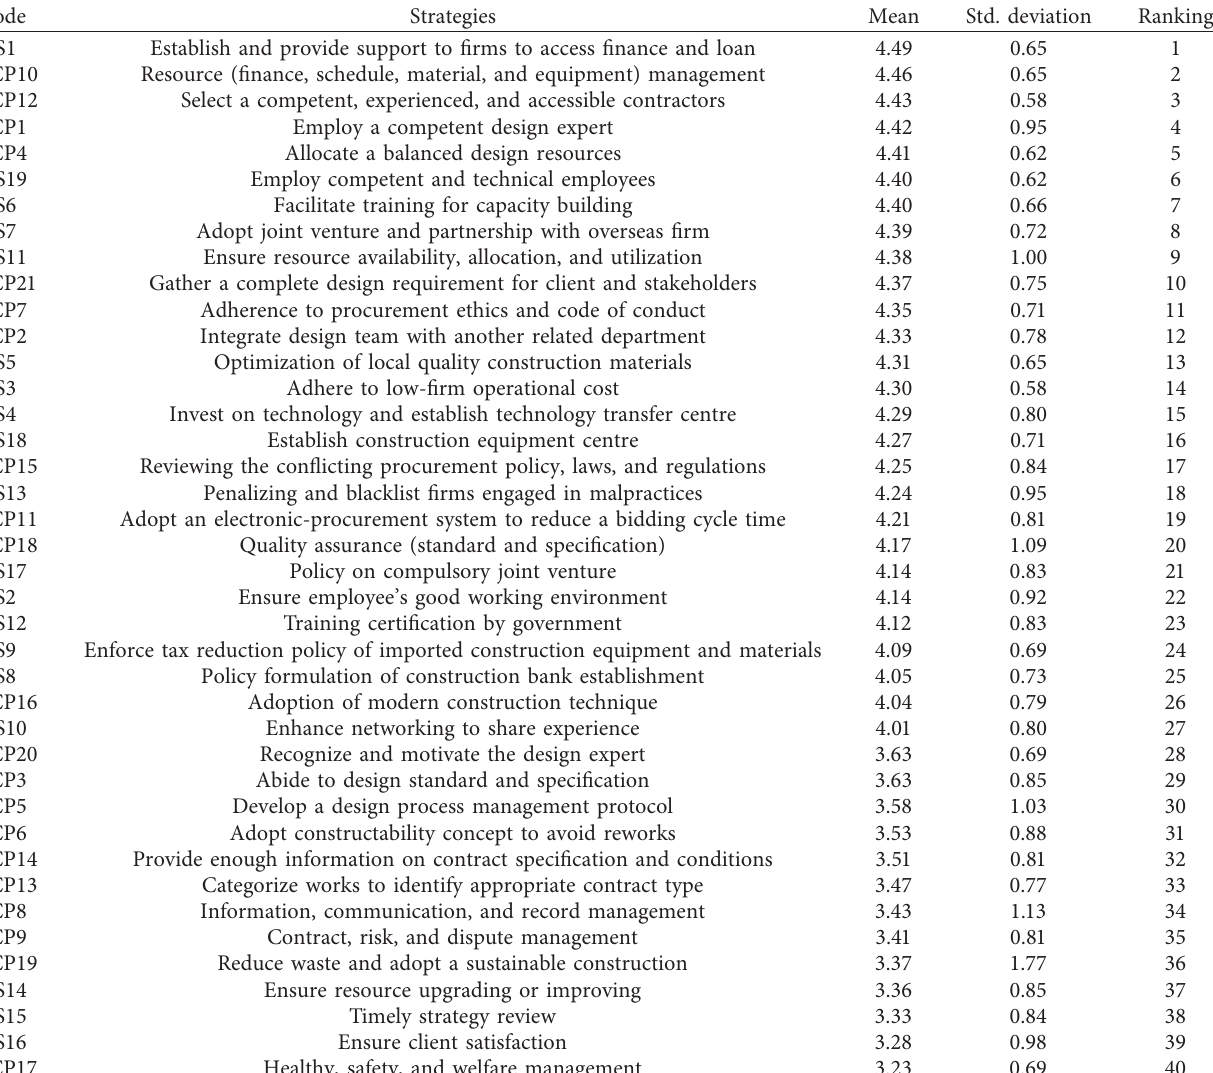
Table 8: Ranking of prioritized strategies for performance